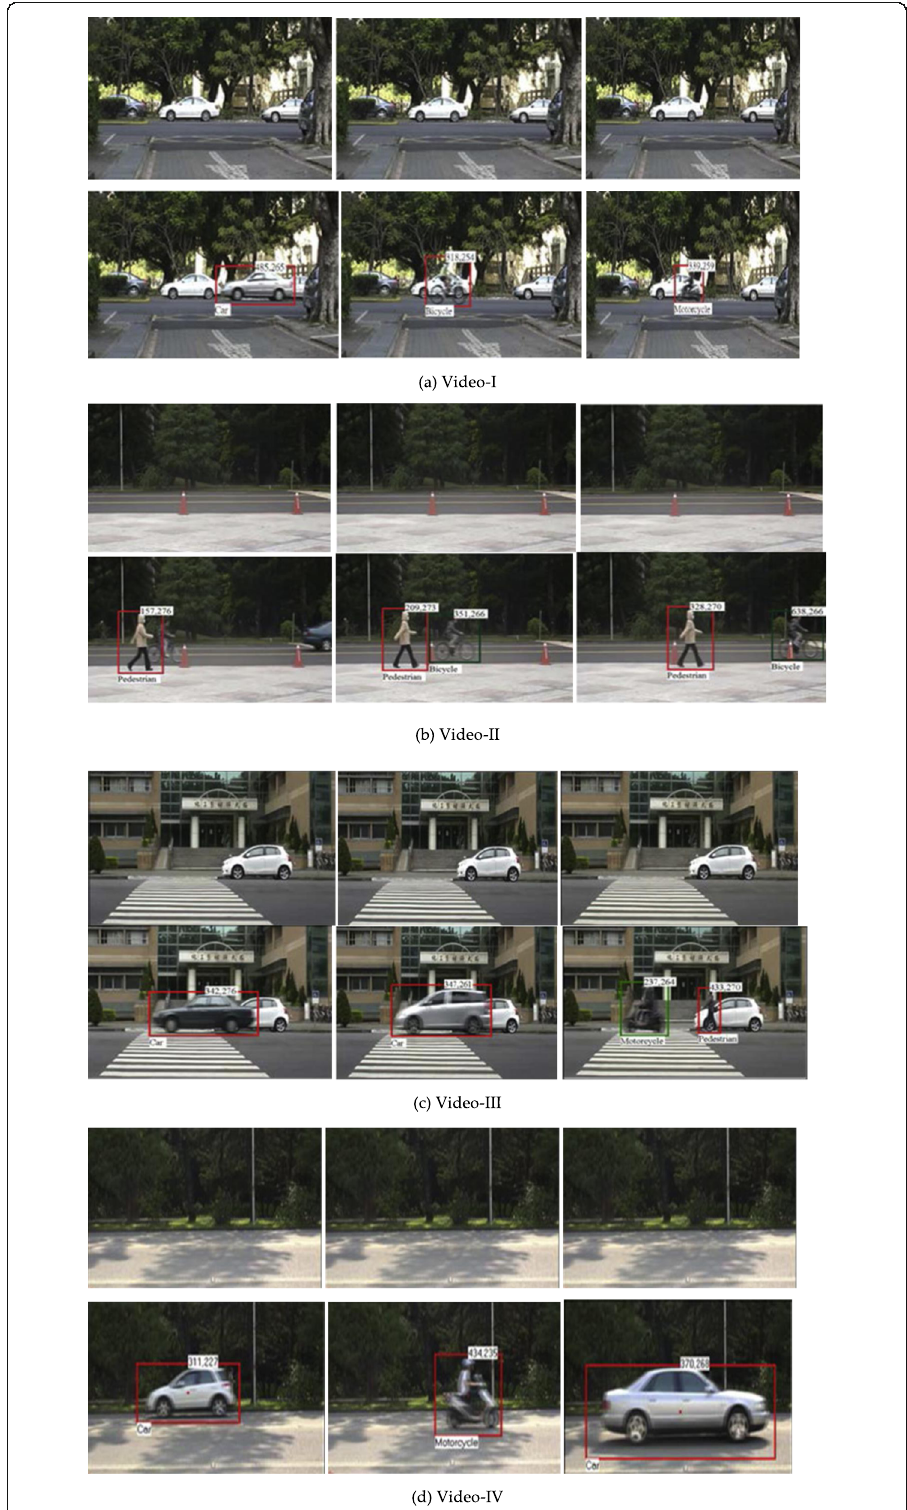
Fig. 3 Classification results of test videos. a Video-I. b Video-II. c Video-III. d